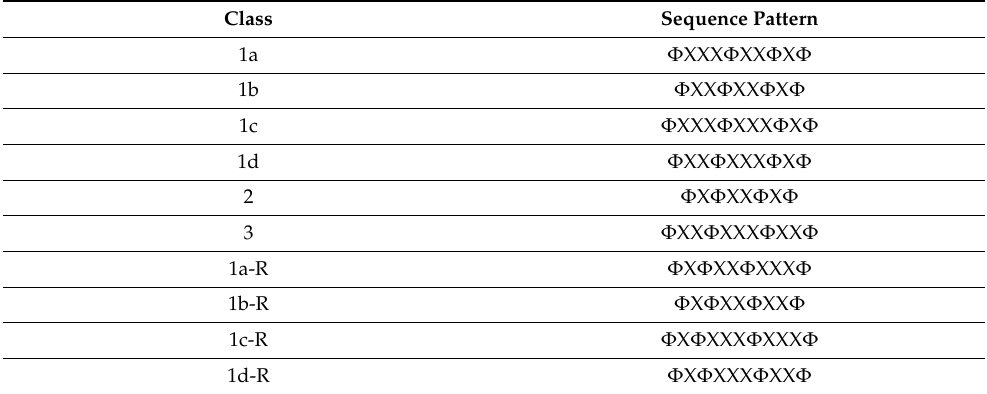
Table 2. NES classes with sequence patterns.